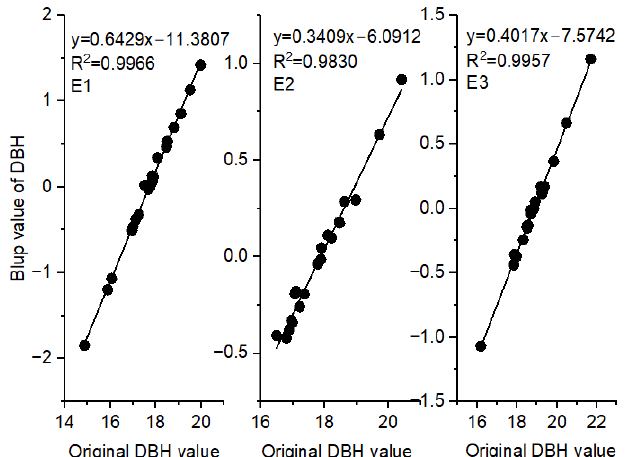
Figure 3. Linear regressions between the original DBH values and the BLUPs of clones at the three sites.